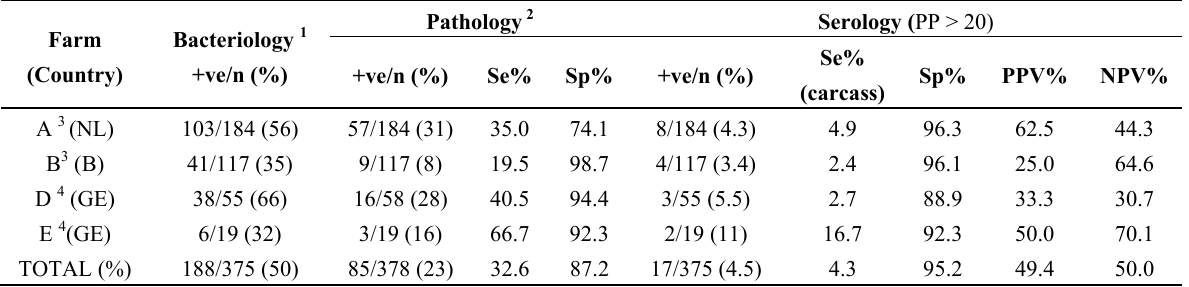
Table 1. Test characteristics of the applied MA-ELISA validated with animals from four positive